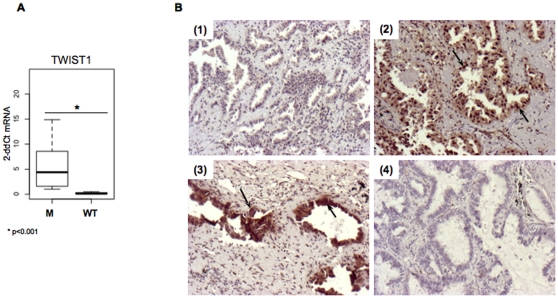
TWIST1 expression in tumor samples.
A. Assessment of TWIST1 expression by quantitative RT-PCR in EGFR mutated (M) and wild type (WT) tumors assessed by quantitative RT-PCR. B. Representative microphotographs (10×) of immunohistochemical expression of TWIST1 in primary EGFR mutated human lung tumors (sample 230 (1), sample 55 (2), sample 288 (3)) or wild type tumors (sample 149 (4)). Arrows point out cells for which staining is positive. TWIST1 positive staining is seen for samples 2 and 3 in cytoplasm and nucleus.